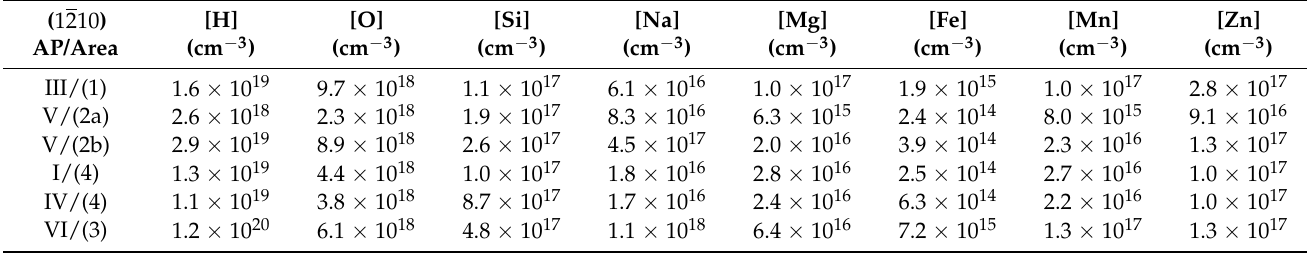
Table 1. Concentrations of the main impurities (donors and acceptors) measured using SIMS on the (cid:0) (cid:1) 1210 slice at six analysis points (APs) (indicated as Roman numerals in circles in Figure 3a) and the corresponding growth areas (indicated as Arabian numerals in brackets in Figure